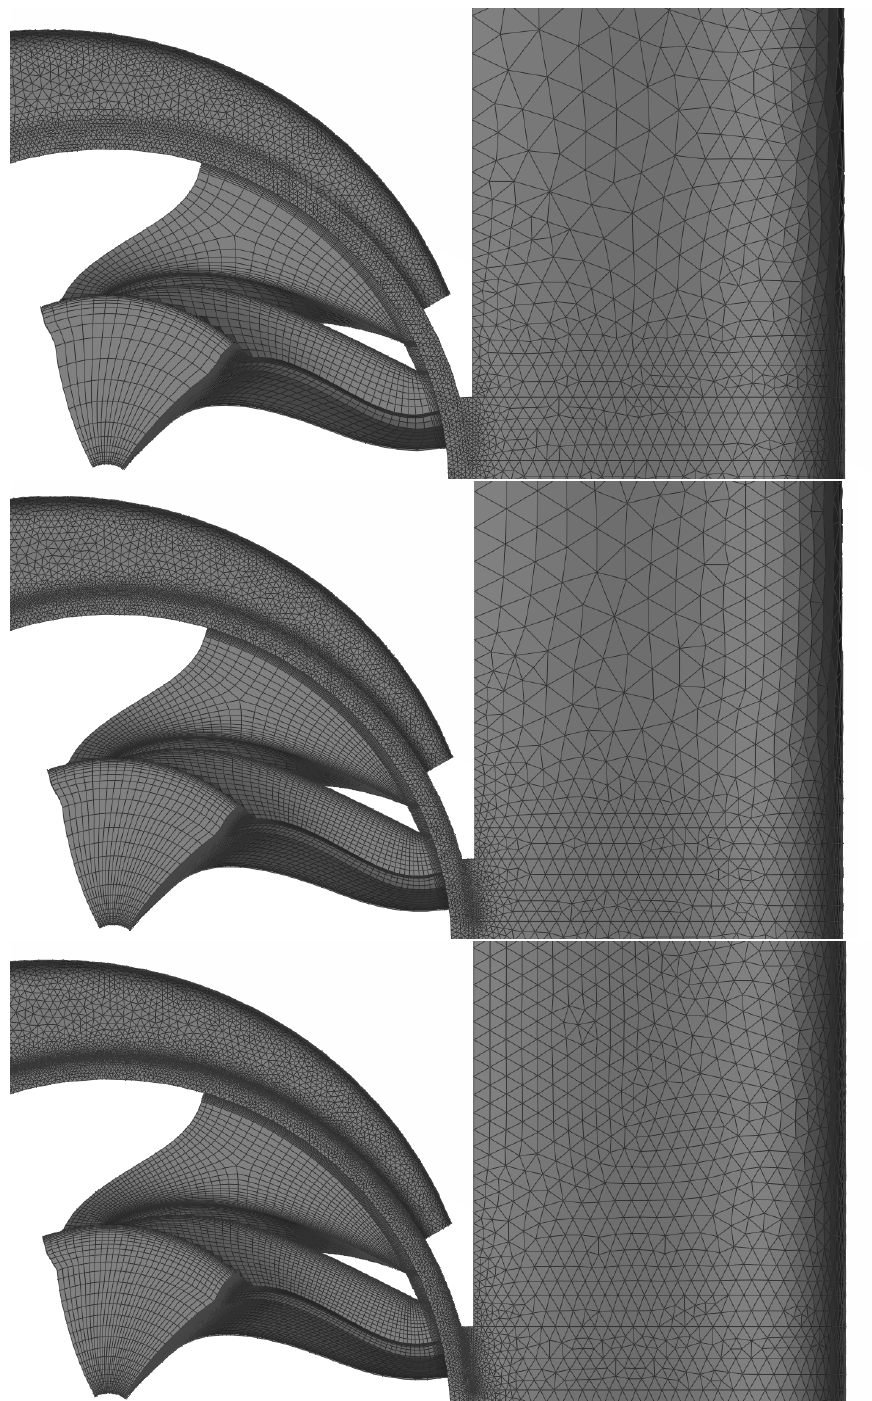
Figure 9. Detail of the coarse ( top ), medium ( middle ) and fine ( bottom ) mesh for the baseline